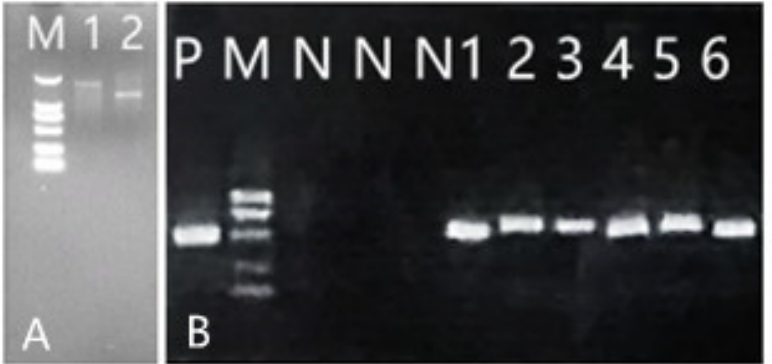
Figure 4. Electrophoresis diagram of RNA extraction from stem tip of B. pervariabilis × D. grandis ( A ); PCR of Bambusa pervariabilis × Dendrocalamopsis grandis transformed vaccine ( B ). M: DL2000 DNA marker; 1, 2, 3 and 4: B. pervariabilis × D. grandis RNA ( A ); M: 1000 DNA Marker (Fermentas); P: Positive control; N: Negative control; 1, 2, 3, 4, 5 and 6: PCR detection results of hyg501 fragment of transformed strain ( B ).